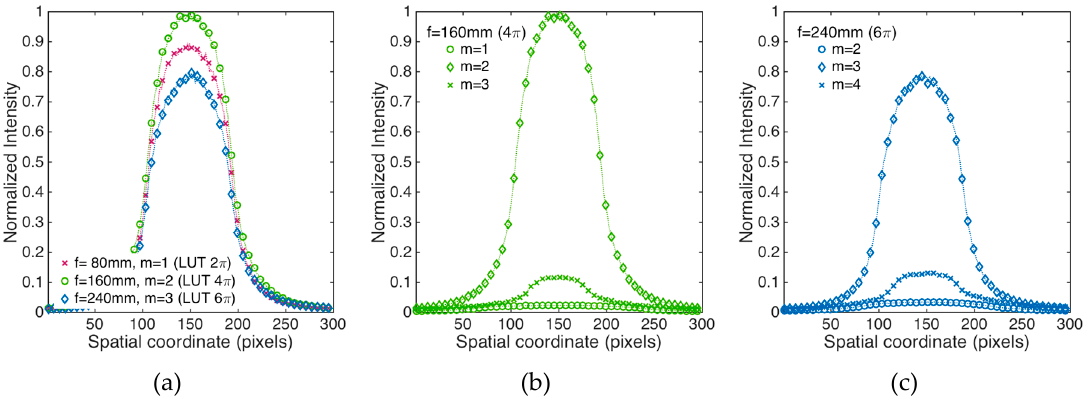
Figure 8. ( a ) Coincident focalization planes at ƒ 0 = 80 mm for first-, second-, and third-order diffraction lenses. Calibrations curves for the linear 2 π (Figure 6b), 4 π (Figure 6d), and 6 π (Figure 6e) responses were used, respectively. Different diffraction orders, at different locations, for ( b ) the second-order diffraction lens with ƒ = 160 mm and ( c ) the third-order diffraction lens with ƒ = 240 mm.